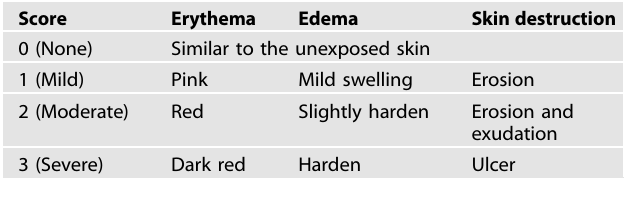
Table 1. Evaluation of UVB-induced skin damage.